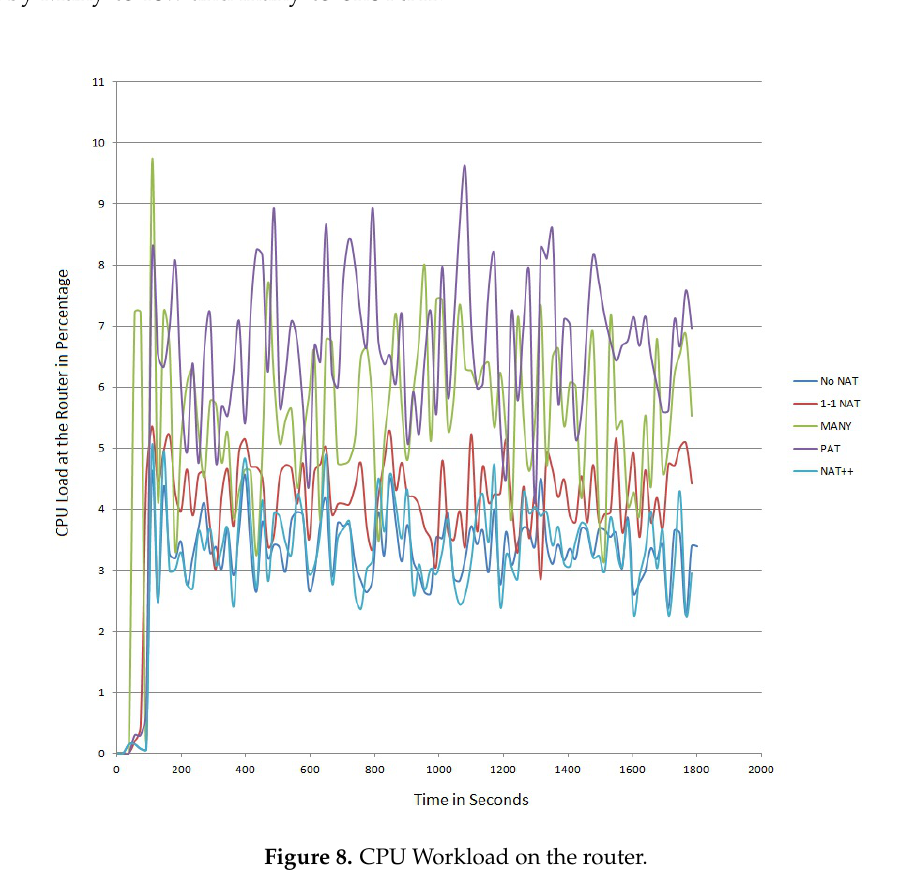
Figure 8. CPU Workload on the